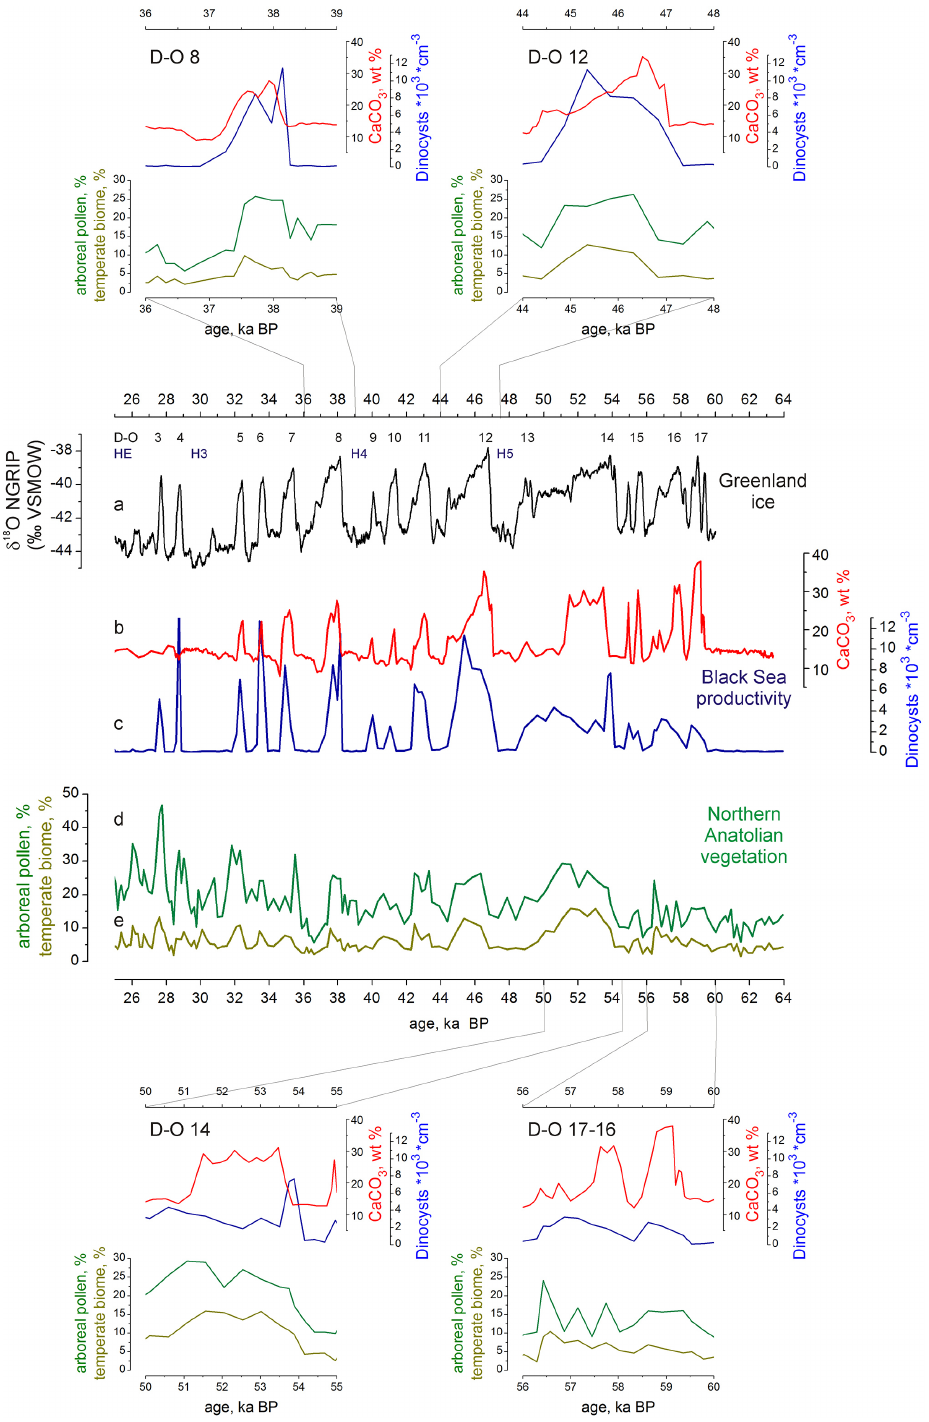
Fig. 6. Northern Anatolian vegetation and the Black Sea productivity in response to D–O and HE climatic variability: (a) δ 18 O record (‰ VSMOW) from NGRIP (GICC05) ice core (Svensson et al., 2008) with numbers of GI and HE marked above the curve; (b) calcium carbonate record from core 25-GC1 (wt%); (c) total dinocyst concentration from core 25-GC1 (specimens × 10 3 cm − 3 ); (d) arboreal pollen (%) and (e) temperate biome (%) from core 25-GC1. The longest GI 17–16, 14, 12 and 8 are plotted in extra graphs, demonstrating a good correlation of northern Anatolian vegetation with the Black Sea productivity